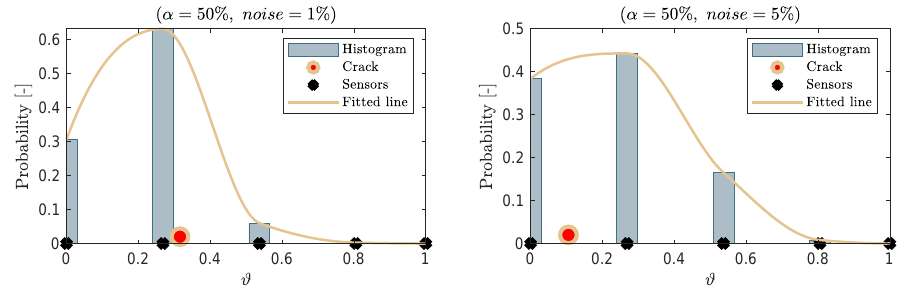
Figure 16. Localizing the damage ˆ ϑ using the curvature algorithm: for ϑ = 0.32, α = 50%, noise = 1%, and d sn = 0.26 ( left ); for ϑ = 0.11, α = 50%, noise = 5%, and d sn = 0.26 ( right